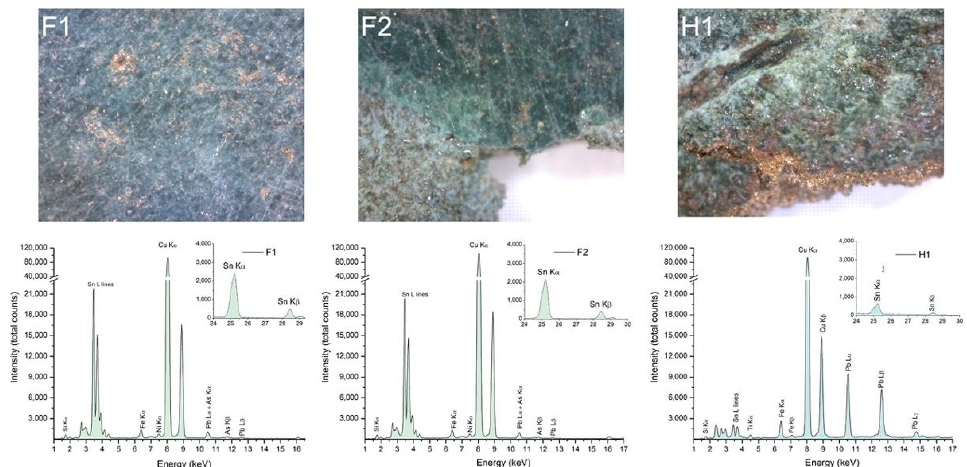
Figure 6. Images of the three bronze fragments at high magnification, acquired using a digital optical microscope and corresponding XRF spectra.